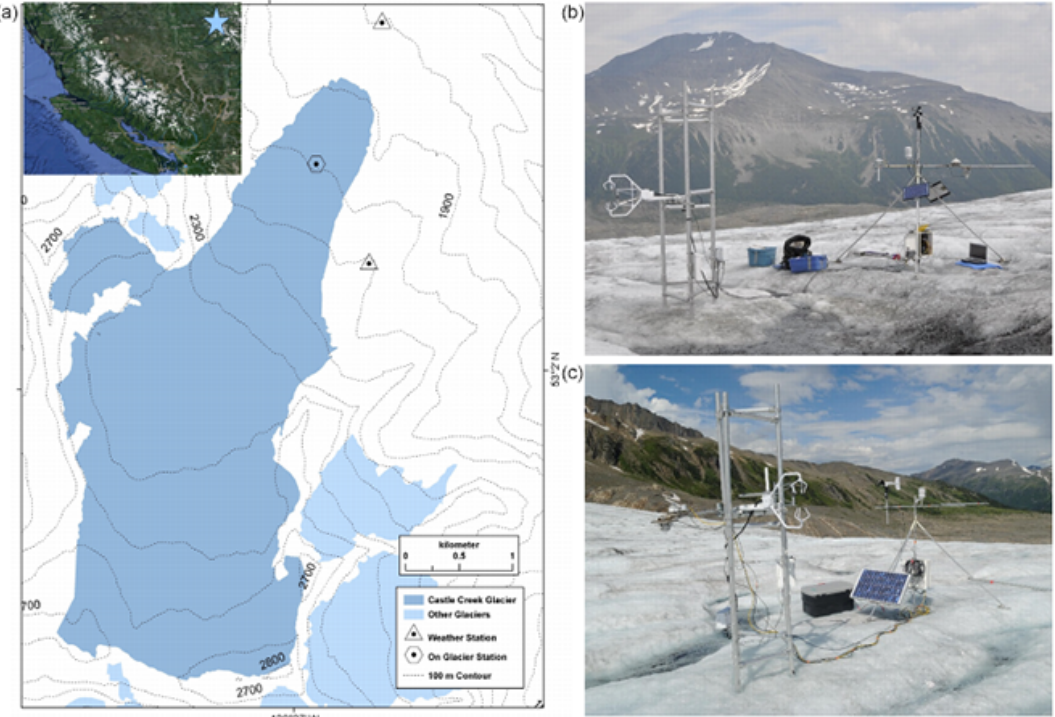
Figure 1. (a) Map of Castle Creek Glacier with locations of automatic weather station on the glacier (AWS glac ) and two AWSs in the glacier vicinity. AWS glac with eddy-covariance tower and floating meteorological tripod during installation, Castle Creek Glacier, (b) 2010 (photo by Theo Mlynowski), (c) 2012 (photo by Valentina